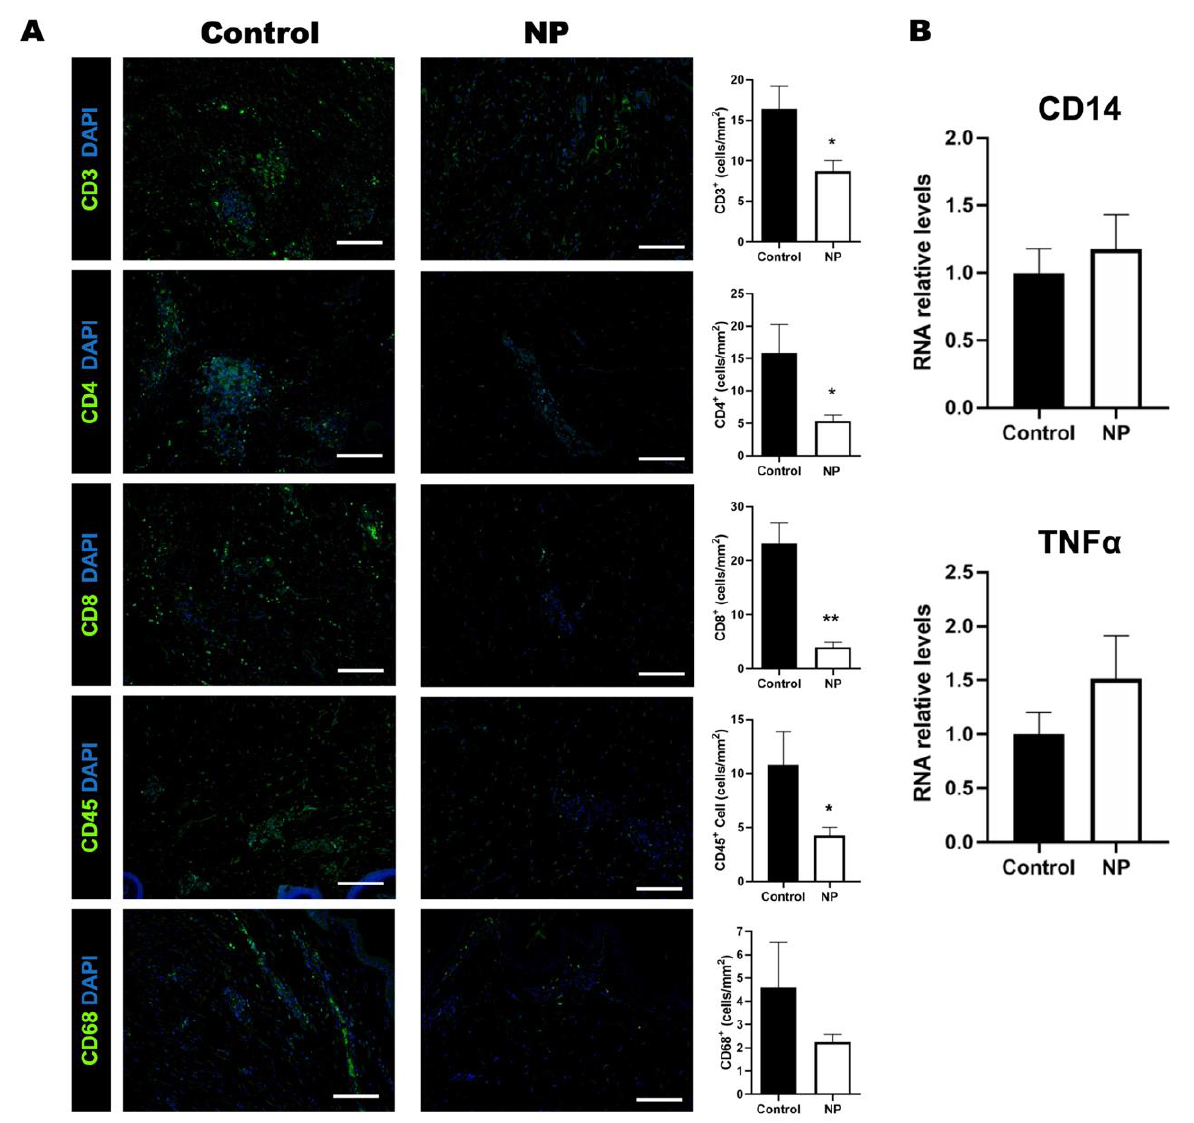
Figure 6. The inflammatory cells reduced following negative-pressure treatment. ( A ) Immunohis- tological staining of CD3, CD4, CD8, CD45, and CD68 (green) in the control and NP groups. The quantification of CD3, CD4, CD8, CD45, and CD68 expressions in the control and NP groups. ( B ) The RNA expression of CD14 and TNFα in the control and NP groups (n = 4). Scale bar: 200 µm. * p < 0.05, ** p < 0.01. Error bar: standard error.